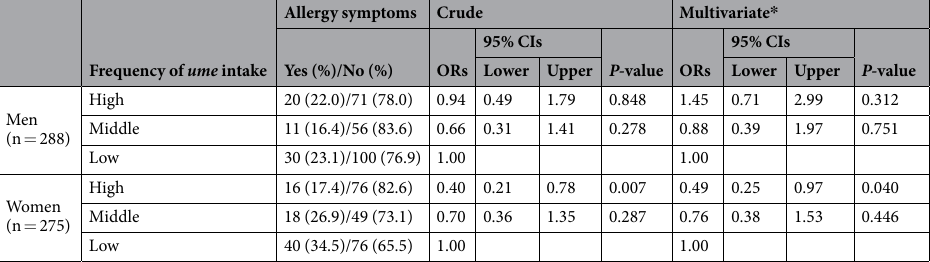
Table 1. Association between frequency of ume intake and allergy symptoms. * Adjusted for age (5 categories), presence/absence of illness (except for allergic disease) and presence/absence of medication (including anti- allergic drugs).OR: odds ratio, CI: confidence interval. High: ≥ 1 ume daily, Middle: < 1 ume daily, Low: ≤ 2 ume weekly or